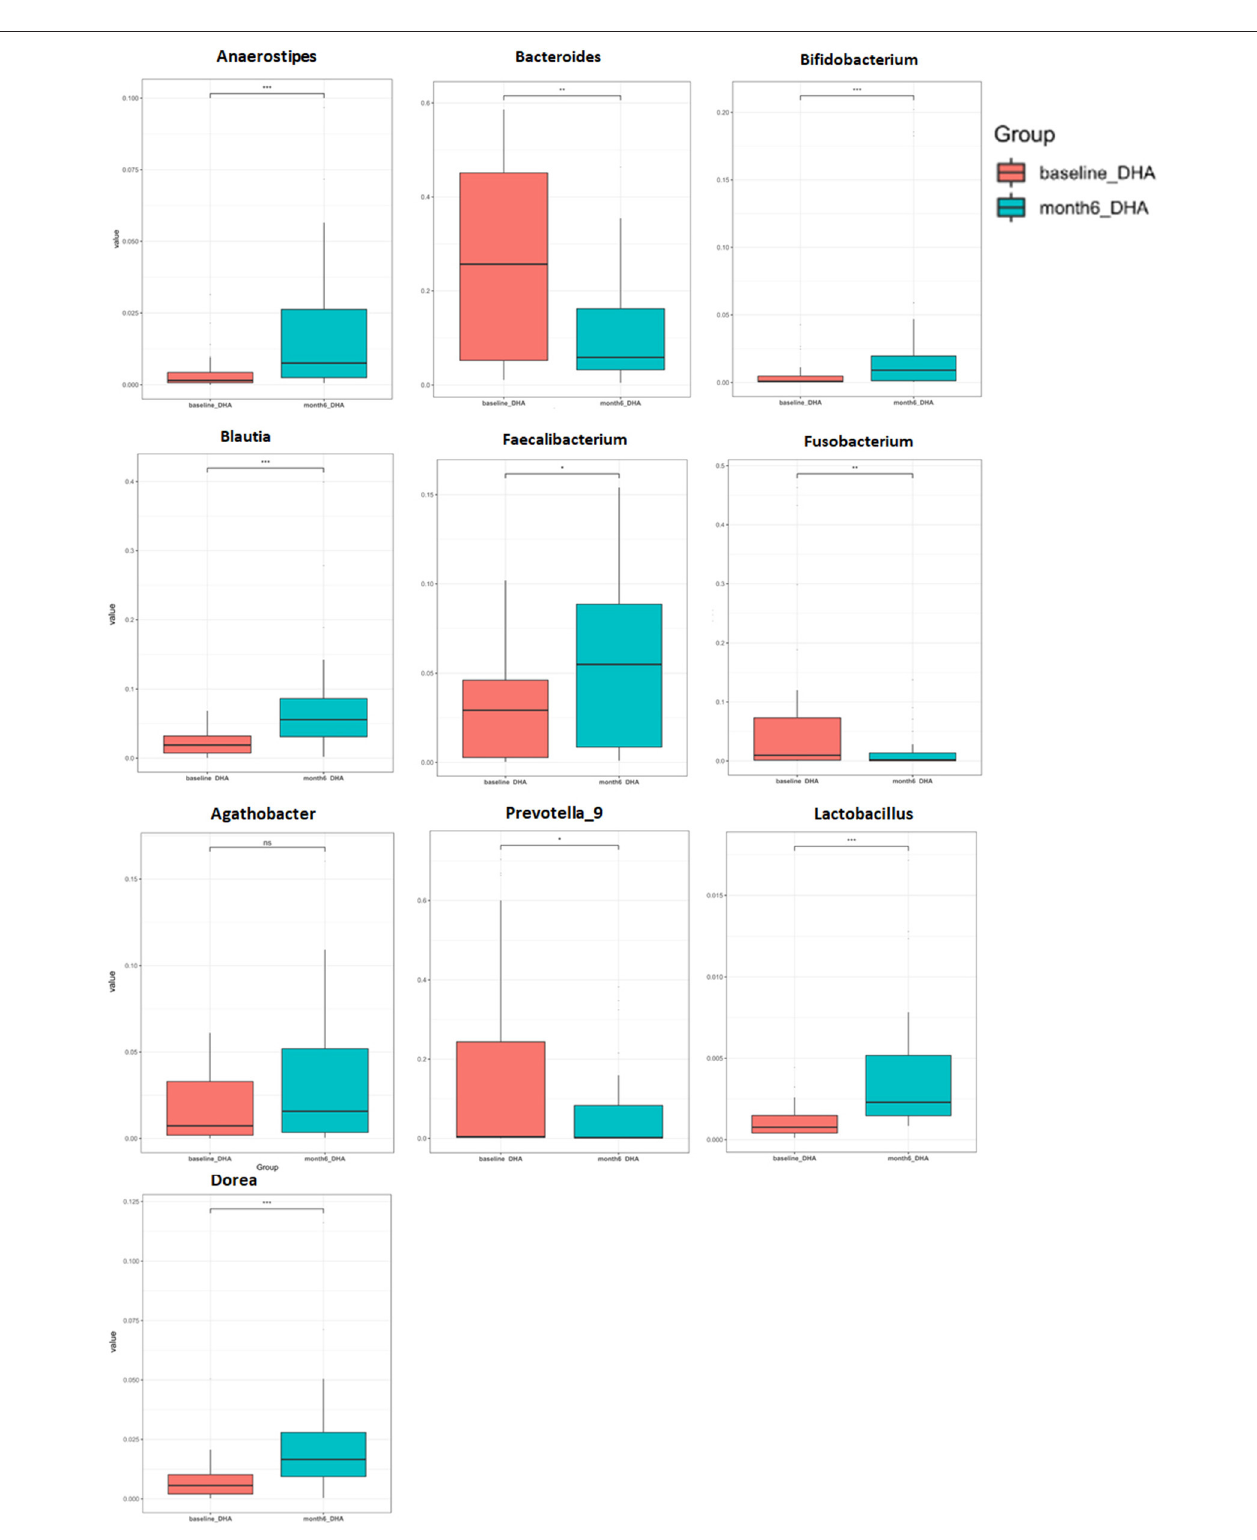
FIGURE 4 | Changes of relative abundance of individual genera after DHA supplement.